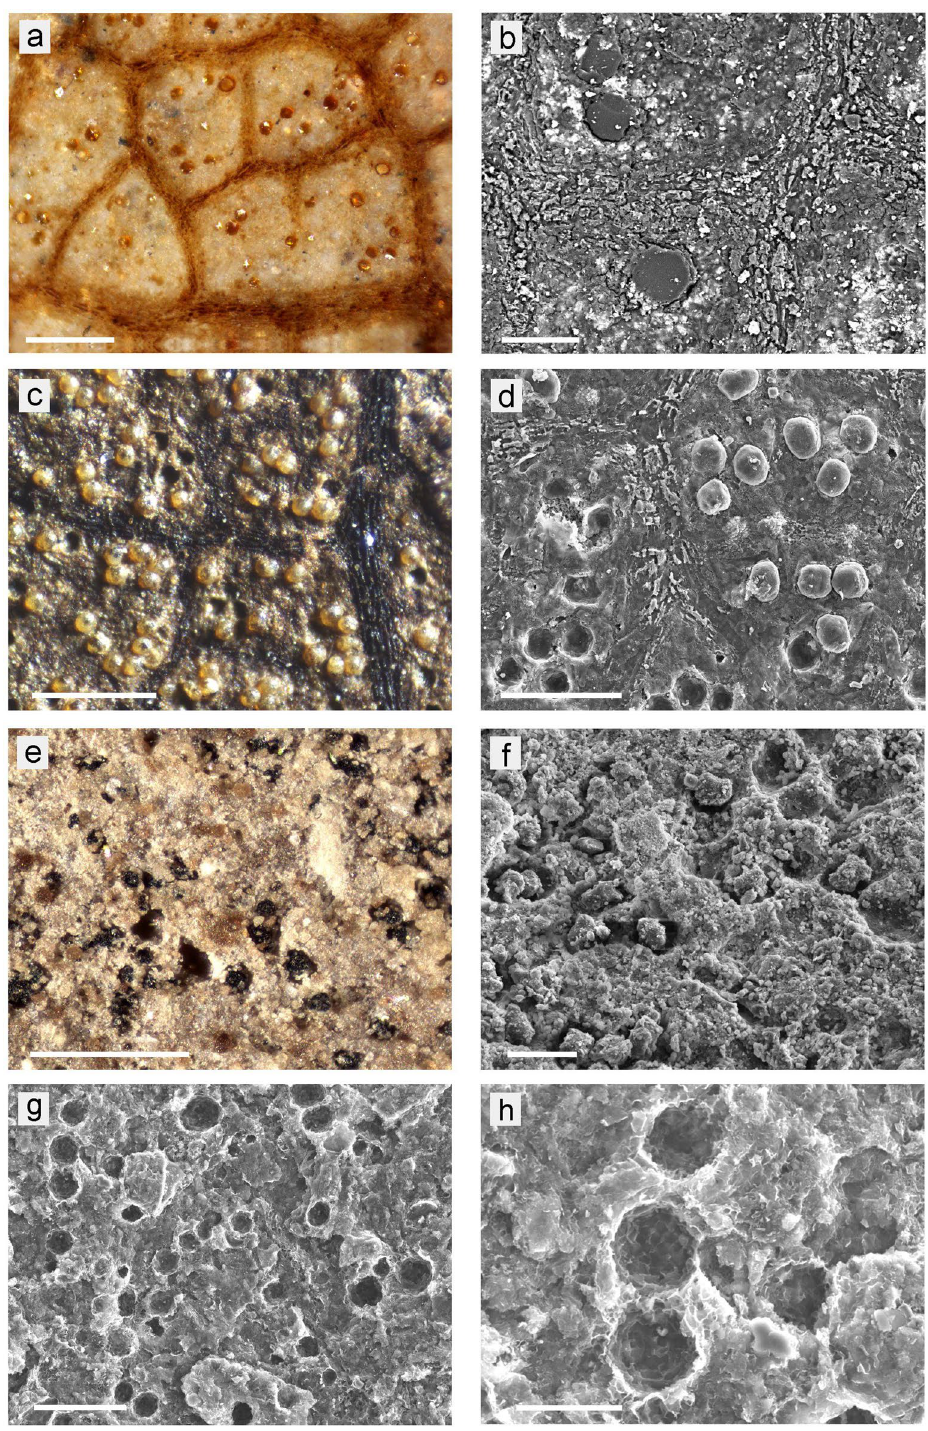
Figure 3. Granular structures in various leaf fossil samples. ( a , c , e ) LM images; surface illumination, 10 × objective; ( b , d , f , g , h ) SEM images. ( a , b ) Sample ‘Ro-2.2’ (‘ Sideroxylon salicites’ ); the LM image ( a ) shows leaf veins and yellow to brown globules of varying sizes embedded in a bright mineral sediment matrix; in the compositional contrast (BSE) SEM image ( b ), the fragmented globules appear dark, indicating organic material; minerals appear bright. ( c , d ) Sample ‘Ro-110.6’ (‘Magnoliopsida’); globules (not fragmented) and holes indicate weak adhesion to the surrounding sediment. Brick-like structures in leaf veins resemble crystals in fresh leaves. ( e,f ) Sample ‘Ro-13.3’ (‘ Nymphaea nymphaeoides ’); LM image shows black serrated particles and (difficult to see) smaller yellow globules. The SEM images shows empty space around granules, perhaps a result of shrinkage. ( g , h ) Freshly cleaved area of the leaf coal sample Ro-59.9; numerous empty cavities of various size, up to 30 µm, are distributed evenly. The detail image ( h ) illustrates the angular shape of the cavities which resemble casts of CaOx druses. Scale bars: ( a , c , e ) = 200 µm; ( b , f , g ) = 50 µm; ( d ) = 100 µm; ( h ) = 20